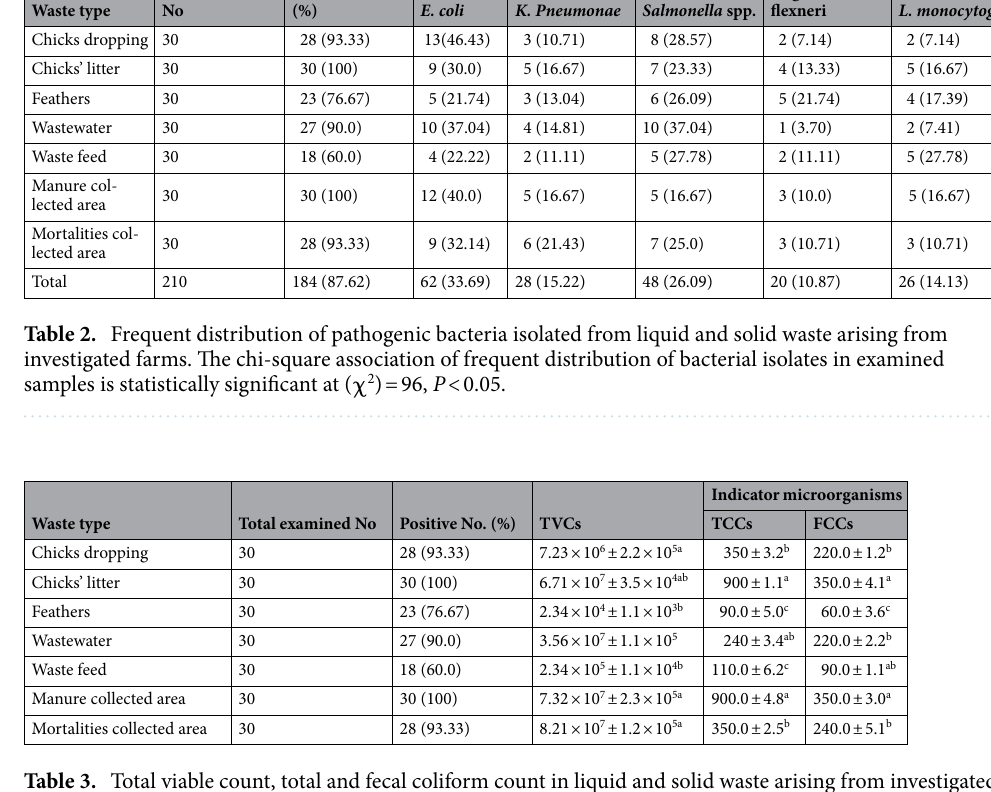
Table 3. Total viable count, total and fecal coliform count in liquid and solid waste arising from investigated farms. TVCs Total viable counts (CFU/mL; CFU/gm), TCCs Total coliform counts (CFU/100 mL; CFU/100gm), FCCs Fecal coliform counts (CFU/100 mL; CFU/100 gm), CFU Colony forming unit. The mean values of TVCs, TCCs, and FCCs in different waste types (mean ± SE) of different superscript letter (a,b,c & ab) of the same column are significantly different at P ≤